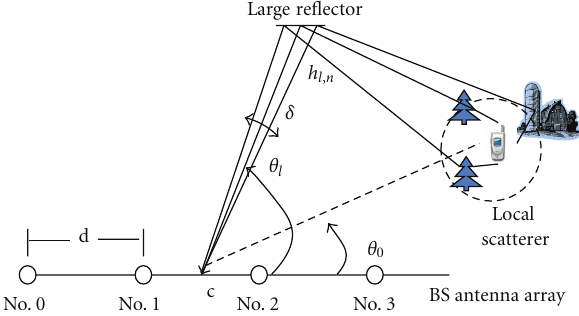
Figure 3: Propagation model of linear antenna